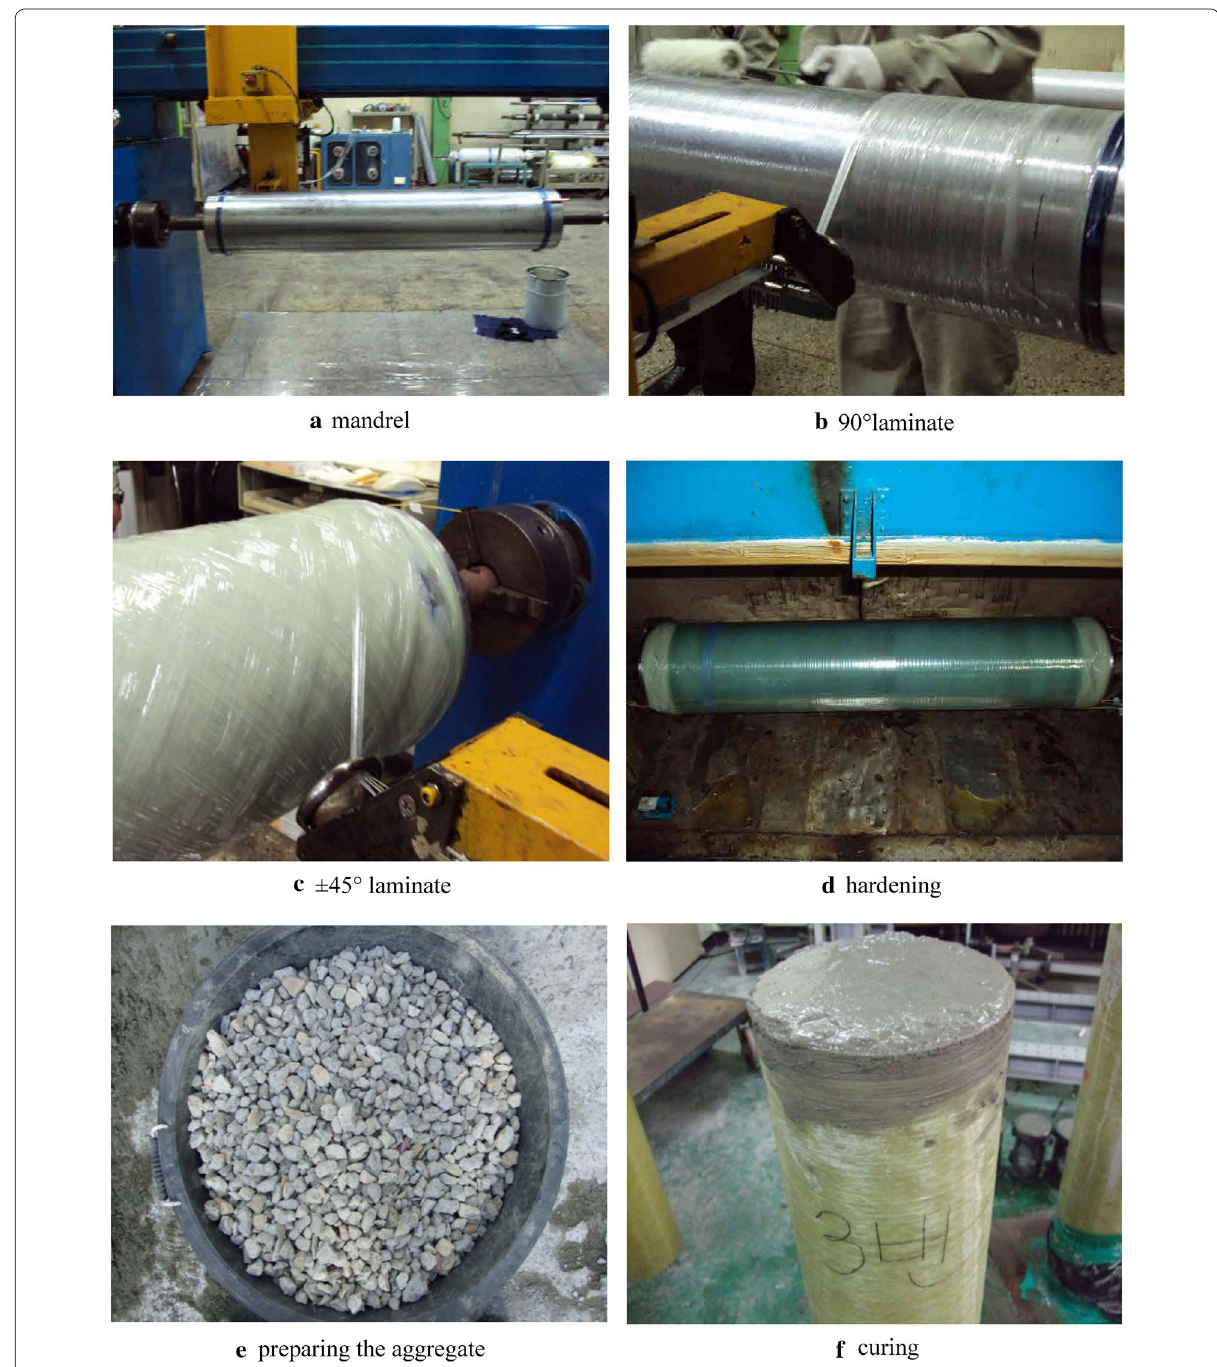
Fig. 1 Fabrication process for